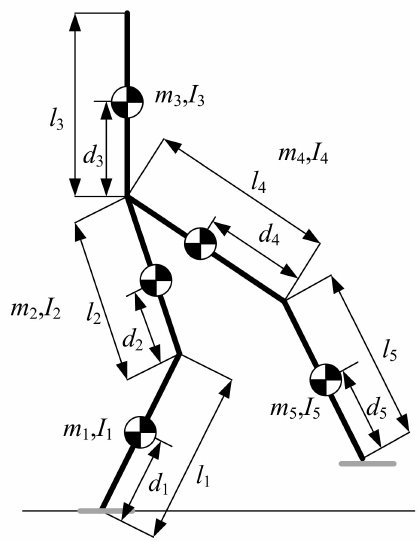
Figure 1. Biped robot model with massless